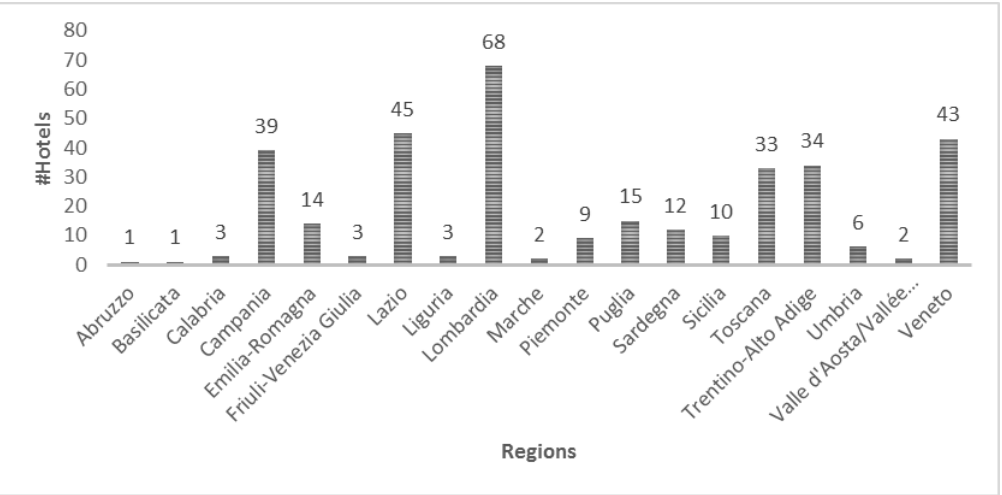
Figure 1. Sample description. Regional-level analysis. Source: Our elaboration on data extracted from AIDA BvD.